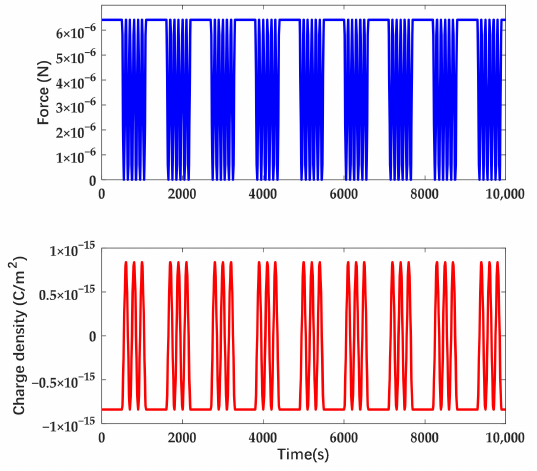
Figure 16. Electrostatic force and surface charge density in neutral area under actuation in the combined waveform.